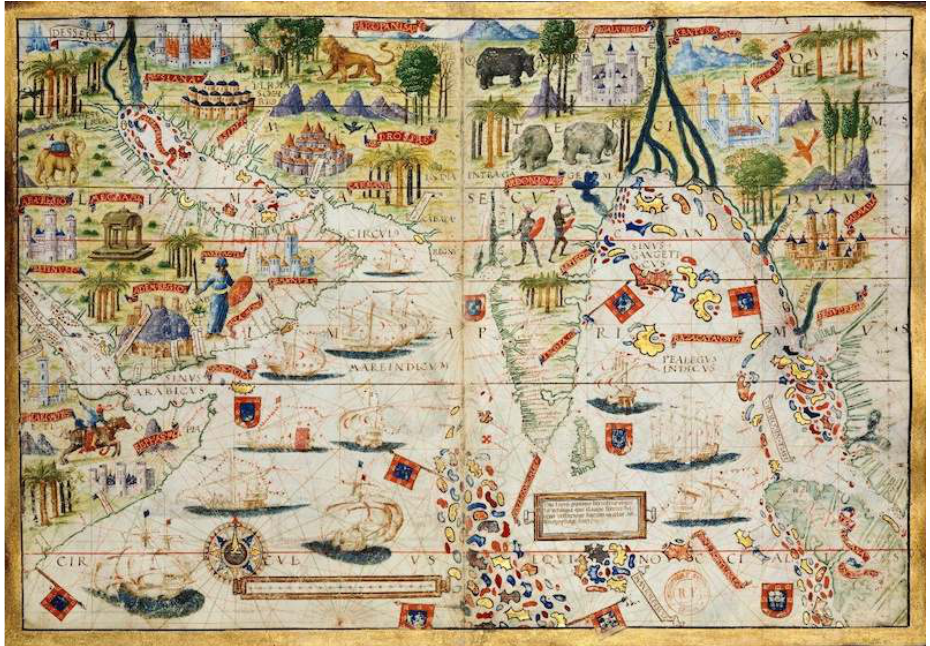
Figure 4. A map of the Indian Ocean